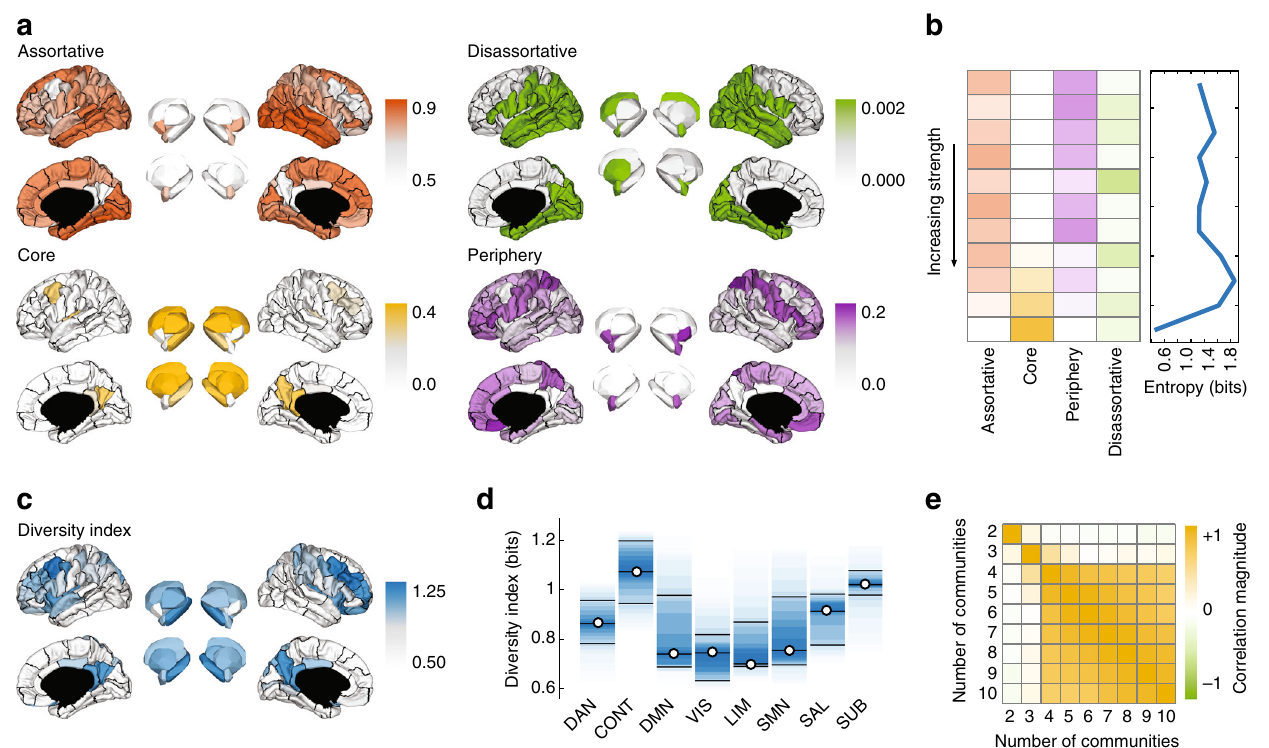
Fig. 7 Regional variation in motif participation highlights diversely connected nodes. a Regional participation in the four community motif types. Note that the scales vary from panel to panel. b Dominance of each motif type as a function of node strength (weighted degree). Note that motif dominance varies with strength; high-strength nodes are predominantly located in the core while low-strength are assortative and predominantly located in the periphery. c Diversity index measuring the entropy across each node ’ s motif participation. d Diversity index grouped by functional system. e Correlation of regional diversity indices as a function of the number of detected communities, K , demonstrating robustness of results across choice of